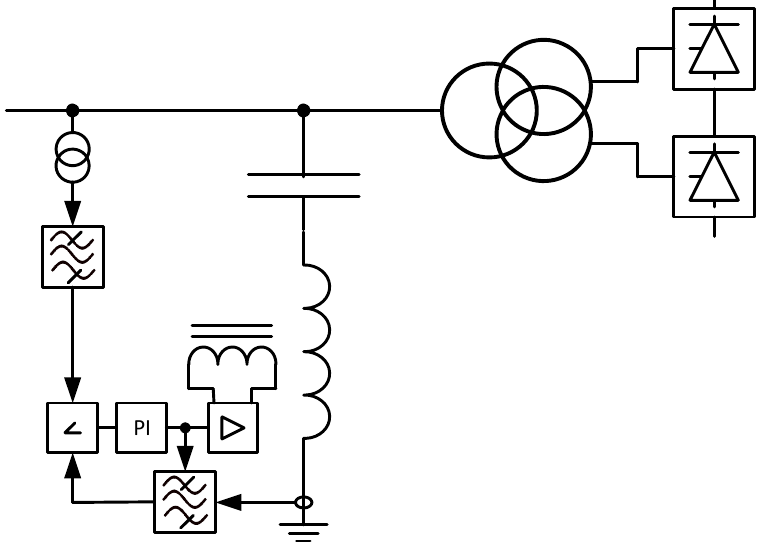
Figure 30. Continuously Tuned AC Filter.